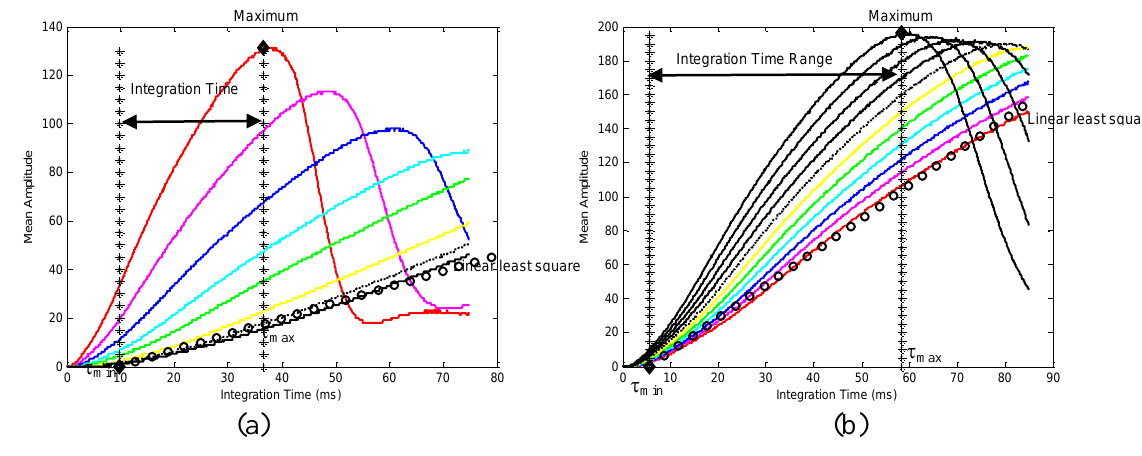
, for the tests of Figure m